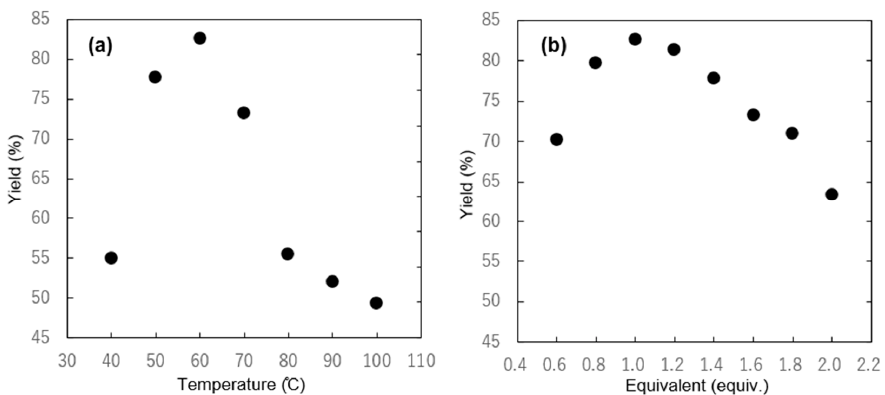
Figure 5. Optimization of ( a ) temperature using 1.0 equivalent of Oxone ® and ( b ) amount of Oxone ® at 60 °C for the synthesis of IBA 2a from 2-IB 1a in the presence of 2.5 mol% FeCl 3 (MeCN/DW (1/1)).